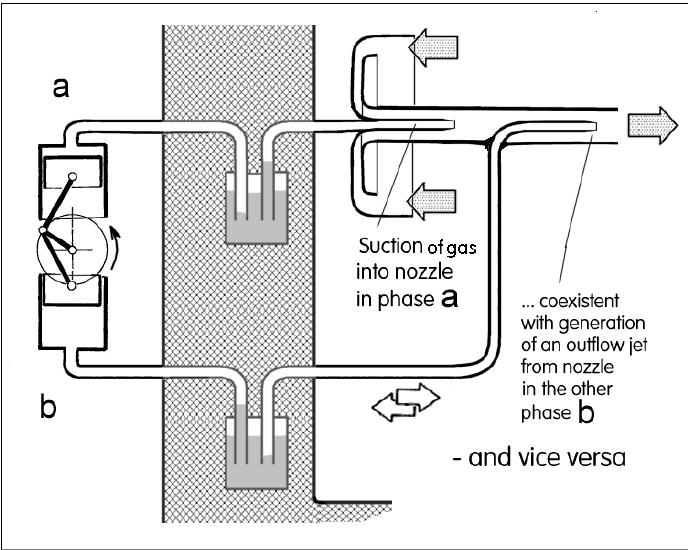
Figure 19. Alternative two-phase driving of the rectified flow with the nozzles arranged in series.